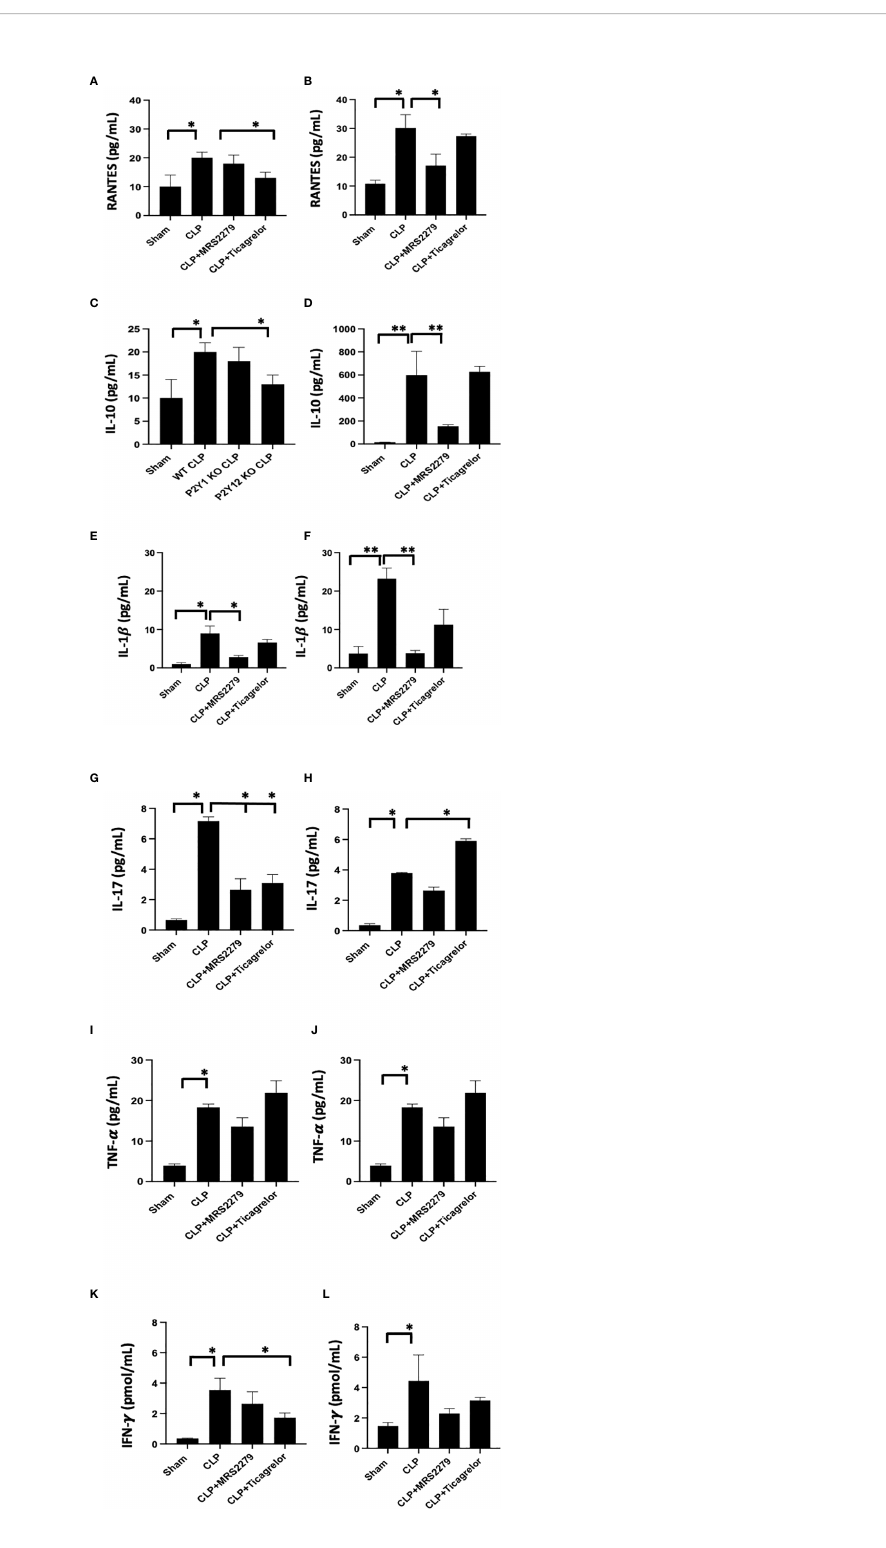
FIGURE 7 P2Y12 or P2Y1 antagonism selectively alters cytokine plasma levels in a sex-speci fi c manner. Plasma samples obtained from each animal were used for detection levels of RANTES (A, B) , IL-10 (C, D) , IL-1 b (E, F) , IL-17 (G, H) , TNF- a (I,J) , and IFN- g (K, L) . Both Sham and CLP samples were analyzed for male and female mice. Mice were treated with MRS2279 (MRS) or ticagrelor. Values are expressed as pg/mL (*P < 0.05; **P < 0.01; n =